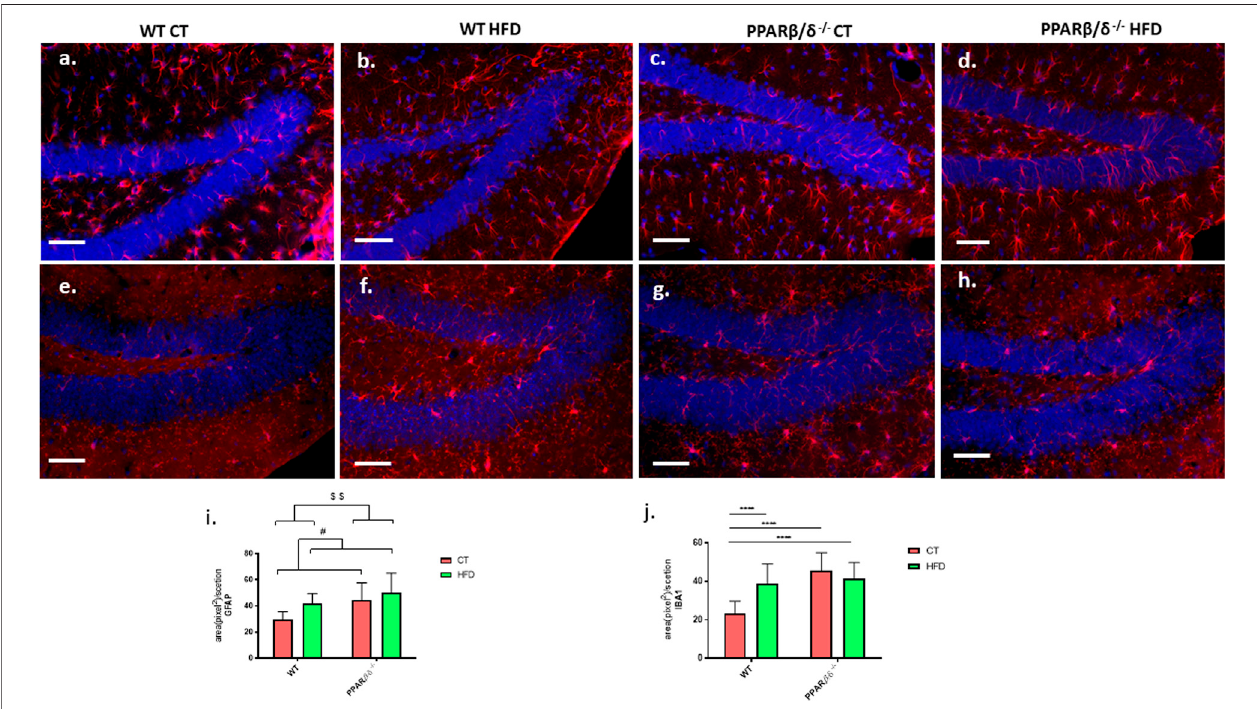
FIGURE5| Evaluation ofin fl ammatory responses. Representativeimages for the detection ofastrocytes (A – D) and microglia (E – H) (redcolor inboth cases) in the DG of the hippocampus. All samples are co-stained with Hoechst for the detection of cellular nucleus (blue). Scale bar: 200 μ m. Graphic representation of fl uorescence intensity for GFAP (I) and IBA1 (J) . In the case of GFAP, statistical analysis was performed through two-way ANOVA (Number of animals ≥ 4) (Control diet vs. HFD: # denote p < 0.05)(WTvs.PPAR β / δ -/- : $$ denote p < 0.01).ForIBA1,two-wayANOVAandTukey ’